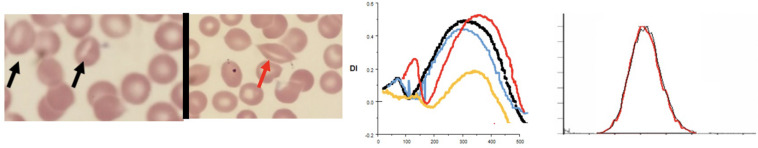
Depiction of smear (black arrows point to classical stomatocytes and red arrow to a “lipstick” stomatocyte, Osmoscans in middle panel- black line: control; yellow line: hereditary spherocytosis, red line: overhydrated stomatocytosis [PIEZO1 (p.Arg1728Cys)], and blue line: dehydrated stomatocytosis [PIEZO1 (p.Thr1589Ile)], EMA histograms in right panel in cases of stomatocytosis overlap control histograms.